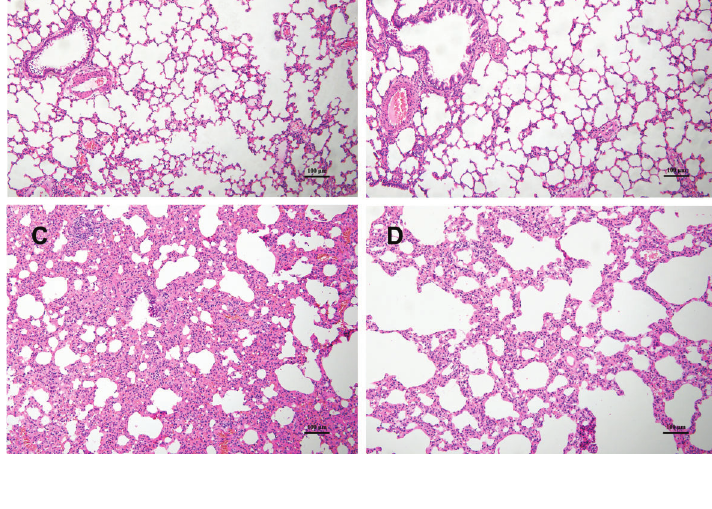
Figure 2. Changes in the levels of proin fl ammatory cytokines (ELISA): A , Interleukin (IL-6); B , tumor necrosis factor (TNF- a ); C , monocyte chemotactic protein 1 (MCP-1), and D , interleukin (IL-8). Data are reported as means ± SE. NC: normoxia control group (n=8); N-A: NC and Ang-(1 – 7) supplement group (n=8); uCIH: untreated chronic intermittent hypoxia group (n=8); CIH-A: CIH and Ang-(1 – 7) supplement group (n=8). *P o 0.05 vs NC; # P o 0.05 vs N-A; + P o 0.05 vs uCIH